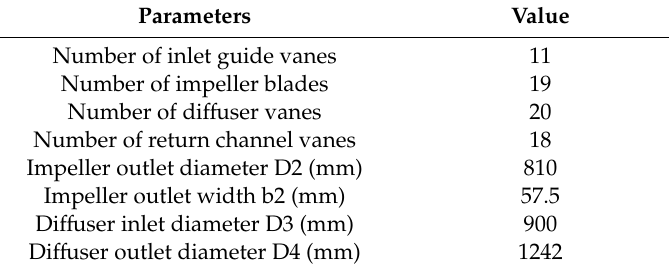
Figure 4. Schematic representation of the experimental test rig. Table 1. Specifications of the investigated compression stage.